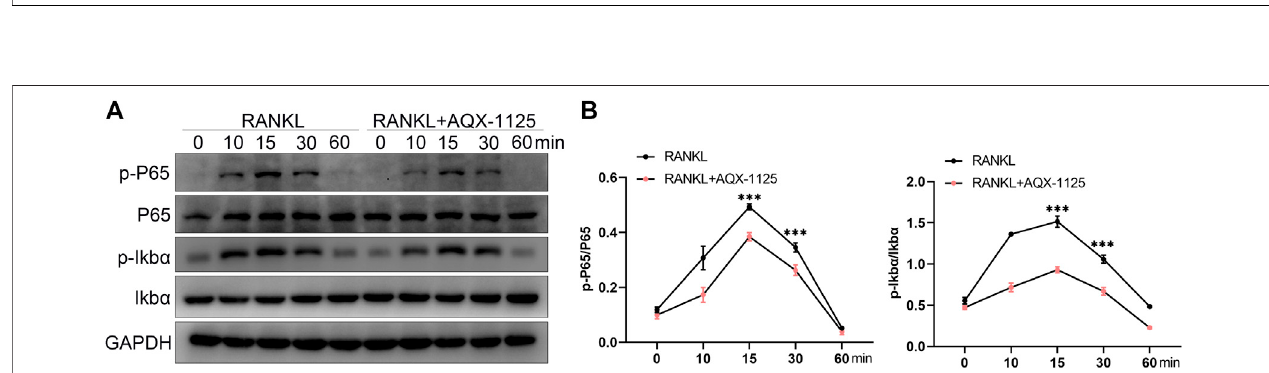
FIGURE 4 | AQX-1125 promotes osteoblast differentiation via the PI3K/Akt signaling pathway. (A) Protein expression levels of PI3K, p-PI3K, Akt and p-Akt in BMSCs were detected by Western blotting after treatment with various concentration of AQX-1125 for 4 days. (B) Quantitativeanalysis of each immunoblot in (A) . Data are presented as means ± SD from three independent experiments (* p < 0.05; ** p < 0.01; *** p < 0.001).